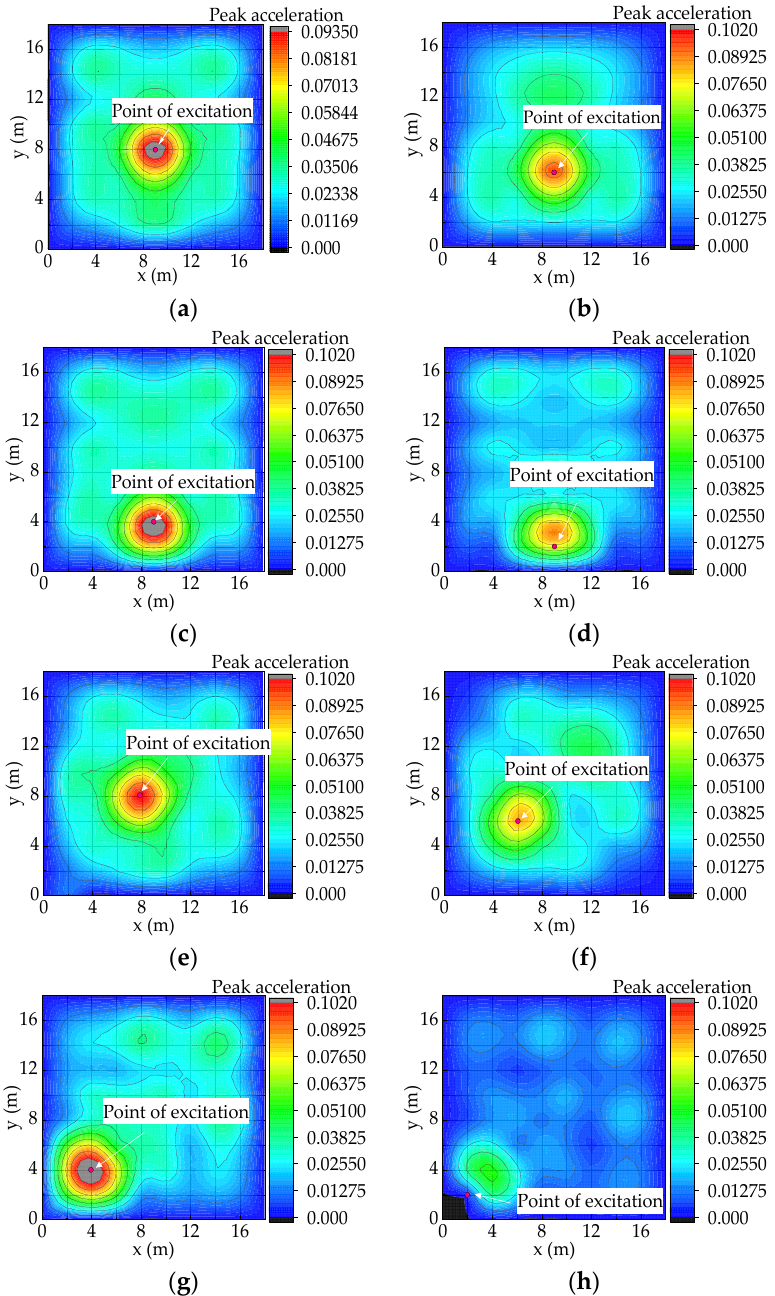
Figure 8. Contour map of peak acceleration: ( a ) point B; ( b ) point C; ( c ) point D; ( d ) point E; ( e ) point F; ( f ) point G; ( g ) point H; ( h ) point I.